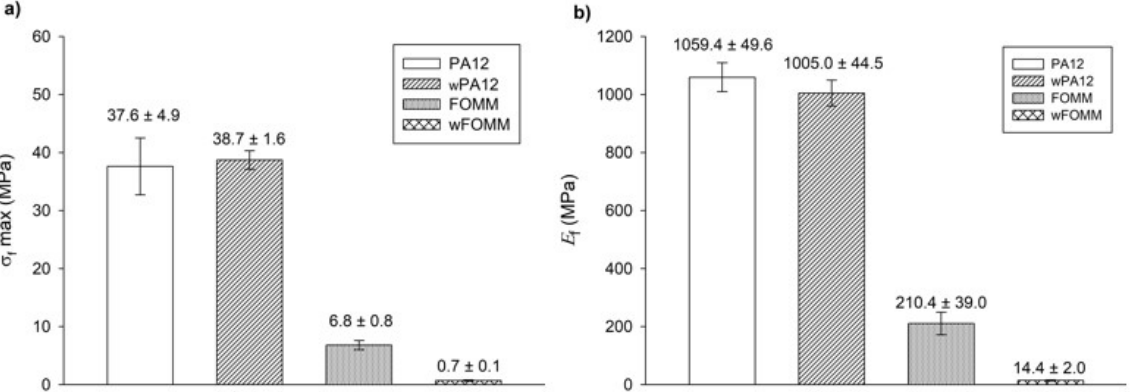
Figure 11. 3PB test: ( a ) maximum flexural strength and ( b ) flexural modulus. Results presented as mean ± SD.